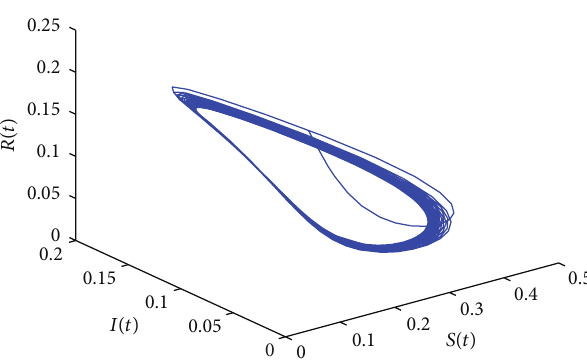
Figure 6: A limit cycle corresponding to the periodic solution in Figure 5 in the S - I - R space.